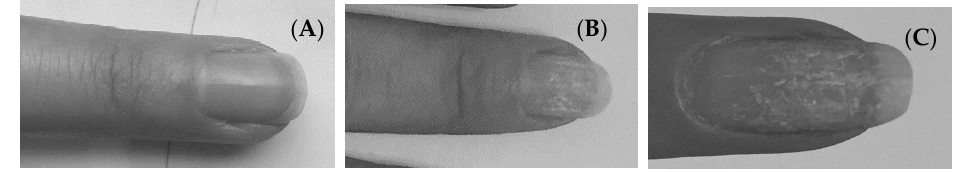
Figure 10. A woman’s nail plate before ( A ) and after ( B , C ) the use of hybrid manicure.